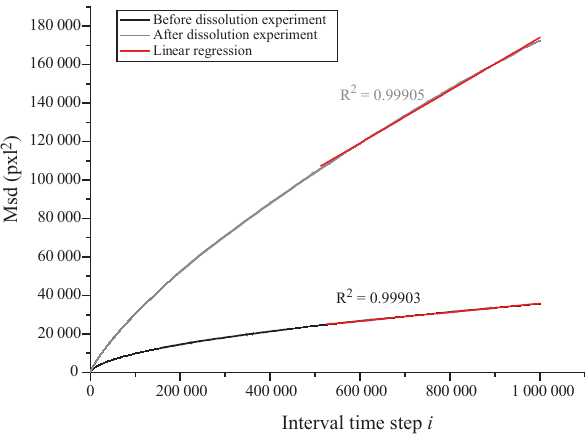
Figure 9. Chord-length function along x , y and z ( P(x,y,z )) for sample Bvl before and after the dissolution experiment.